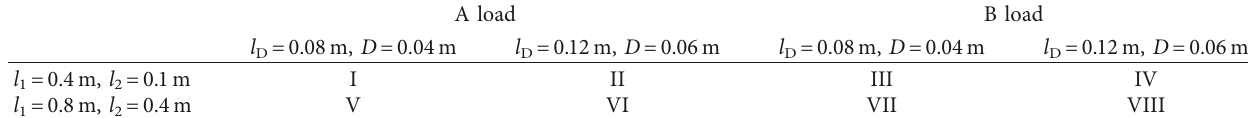
Table 1: Influence parameters of each parallel test.